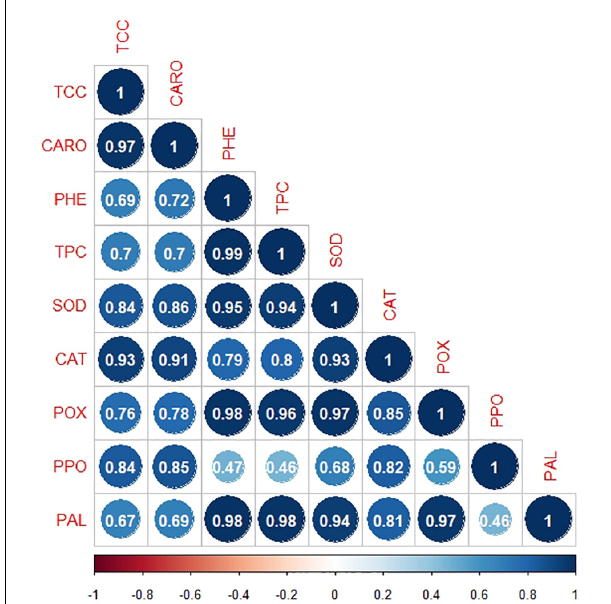
FIGURE 2 | Correlation matrix of physio-chemical attributes (TCC, total chlorophyll content; CARO, carotenoids; PHE, total phenolic content; TPC, total protein content; SOD, superoxide dismutase; CAT, catalase; POX, peroxidase; PPO, polyphenol oxidase; PAL, phenylalanine ammonia-lyase) under the effect of Bacillus subtilis (BS-01) and mineral nutrients [Zn (2X: 10 kg acre − 1 ) and NPK (64:46:50 kg acre − 1 )] in tomato plants inoculated with Alternaria solani (AS) in the field after 10 and 30 days of pathogen inoculation (DPI). strong association, r = 0.46–0.59 significant at p ≤ 0.05; Values with different superscript letters in columns show a significant difference